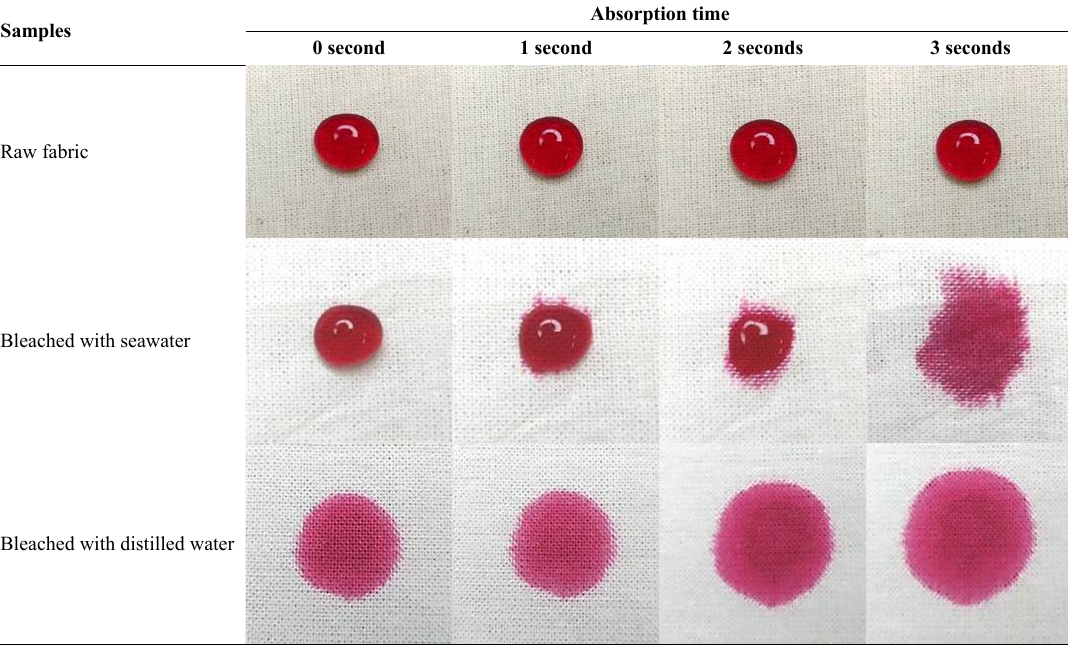
Table 5. Absorption time of dye solution drop.